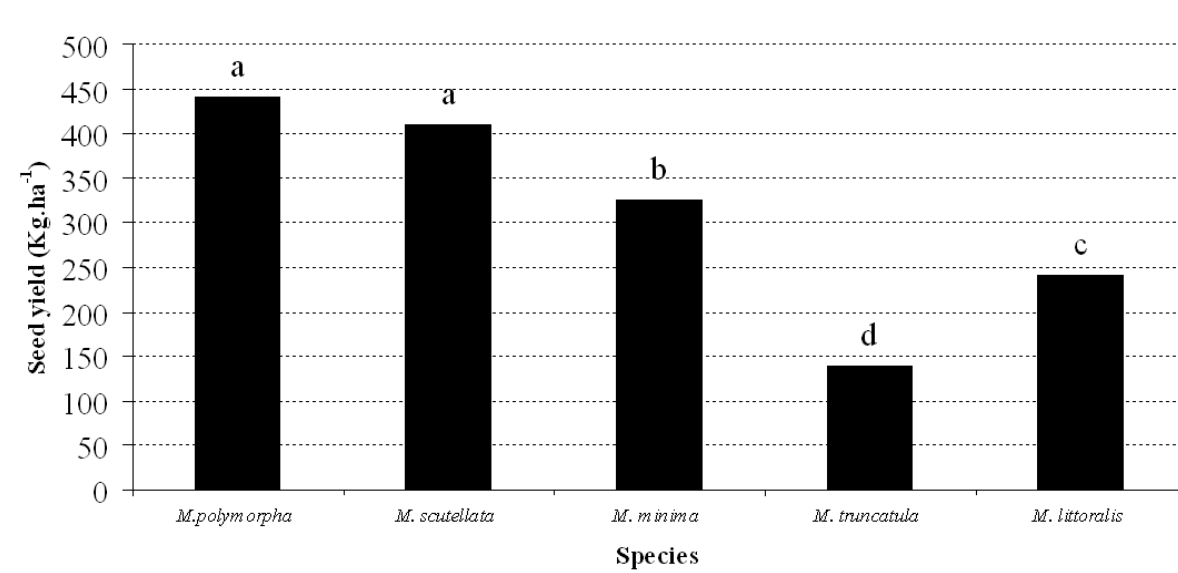
Fig. 2. Main effects of species on seed yield. All the values followed by the same letter in each column are not statistically different at the p<0.05 probability